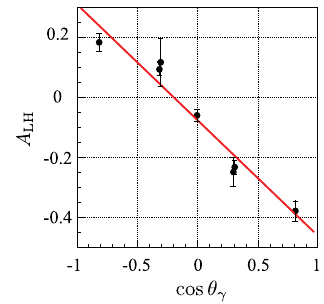
Figure 8. Angular distribution of A LH as defined in Eq. (13). The red line is a linear fit to the measured values (black points).